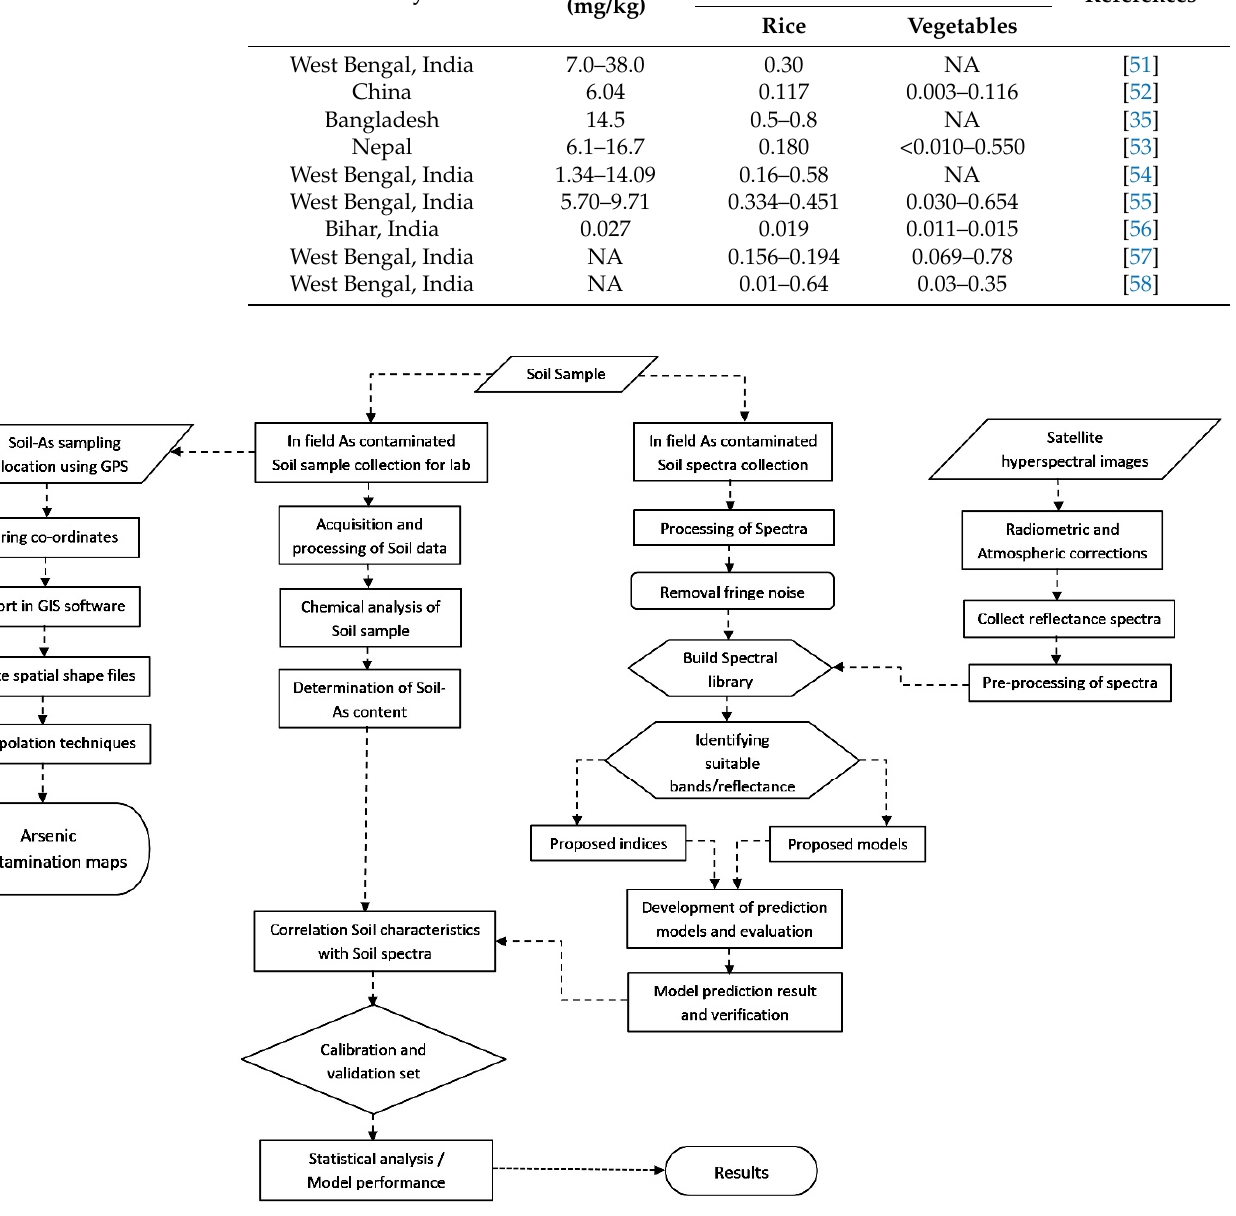
Figure 2. Flowchart for identification of As content in agricultural soil.